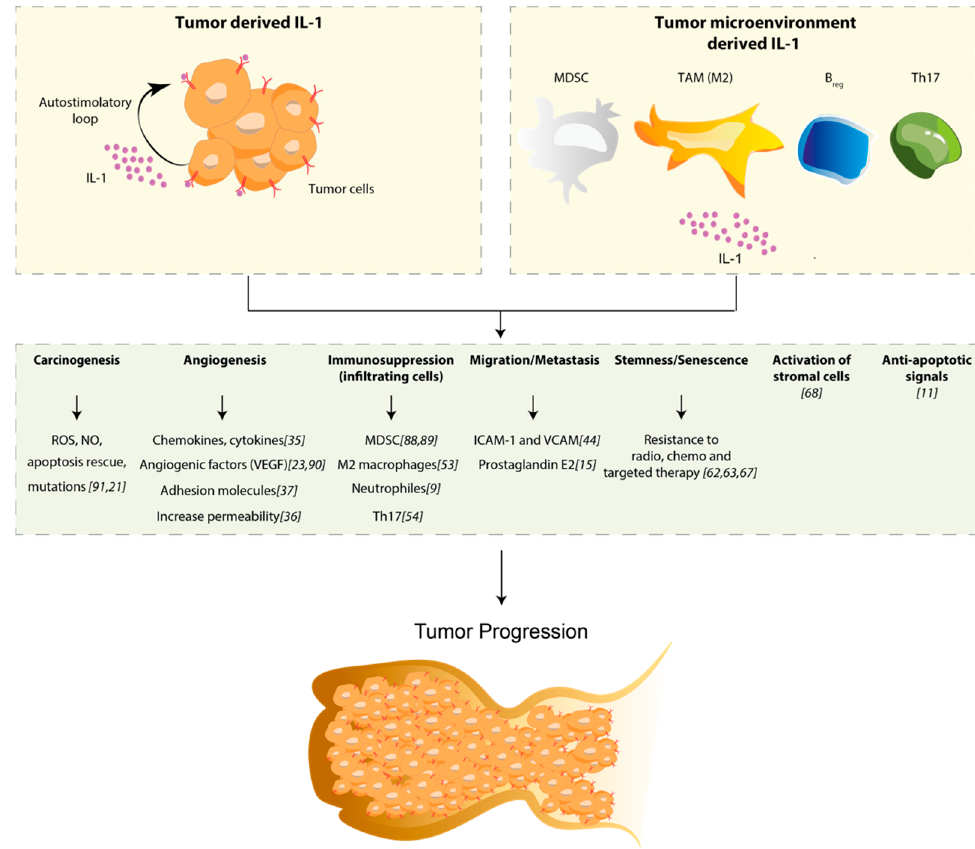
Figure 1. Schematic representation of the role of IL-1 in tumor progression. The upper panel represents two sources of IL-1. Specifically, the tumor-derived IL-1 (upper left) establishes an auto-stimulatory loop that sustains IL-1 synthesis and release, while the tumor microenvironment-derived IL-1 (upper right) arises from immune cells of the myeloid origin: myeloid-derived suppressor cells (MDSC), macrophage-polarized M2 phenotype, regulatory B (Breg) and T helper (Th17) cells. As shown in the figure, the boost of IL-1, released from both tumor and immune cells, induces a wide range of effects: it sustains the production of Reactive Oxygen Species (ROS), and Nitric Oxide (NO) that exacerbate mutation rate rescuing cells from apoptosis; it increases the production of chemokines, cytokines and all adhesion molecules responsible for vascular permeability, leading to angiogenesis and metastasis. It recruits immunosuppressive cells (MDSC, M2 macrophages, neutrophils and Th17) and activates stromal cells in the TME [88–91]. Finally, IL-1 is described to be involved in drug resistance through the induction of anti-apoptotic signals and senescence.